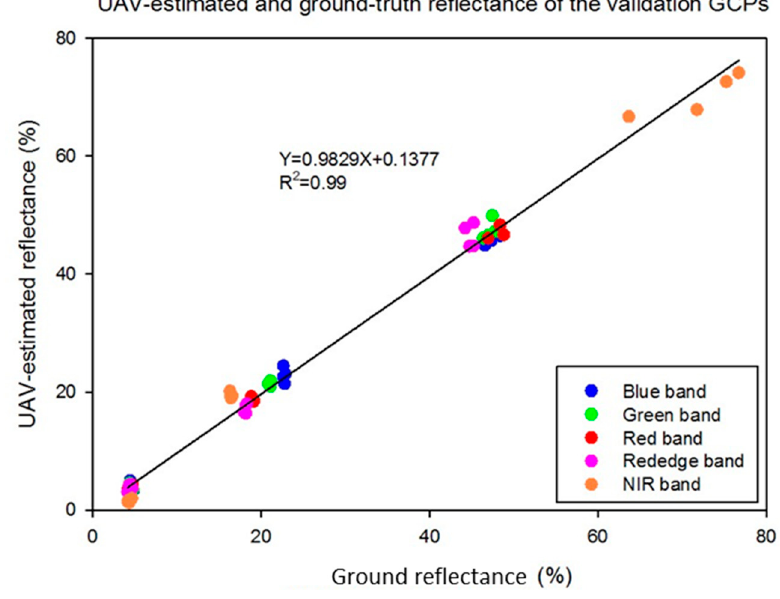
Figure 12. Correlations between UAV-estimated reflectance and ground reflectance for all five bands.